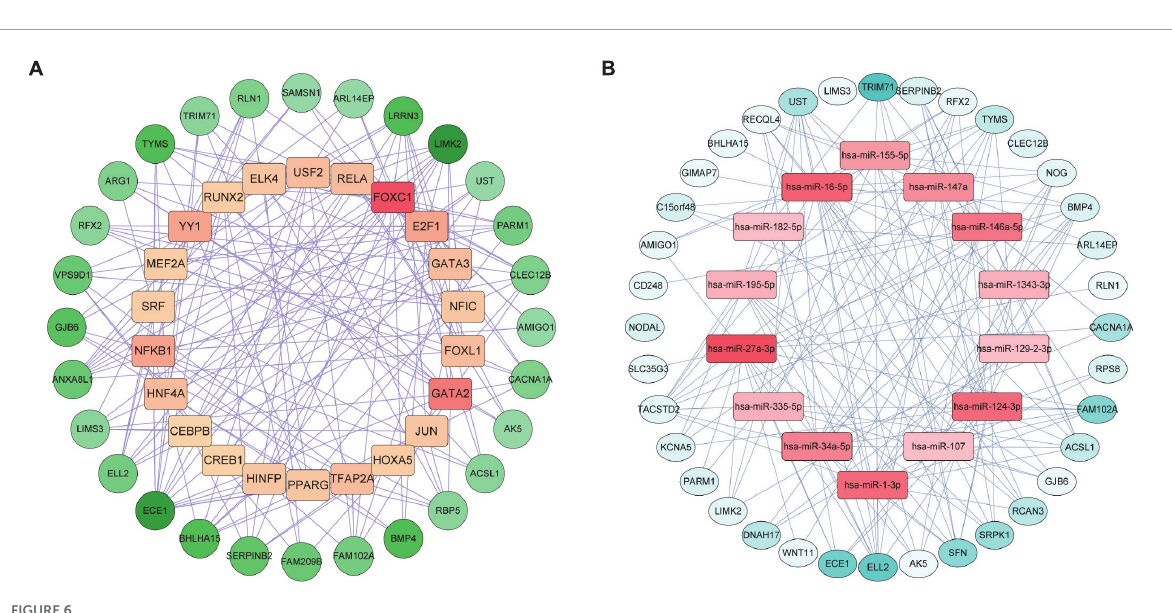
severity of COVID-19, and reduce the occurrence of